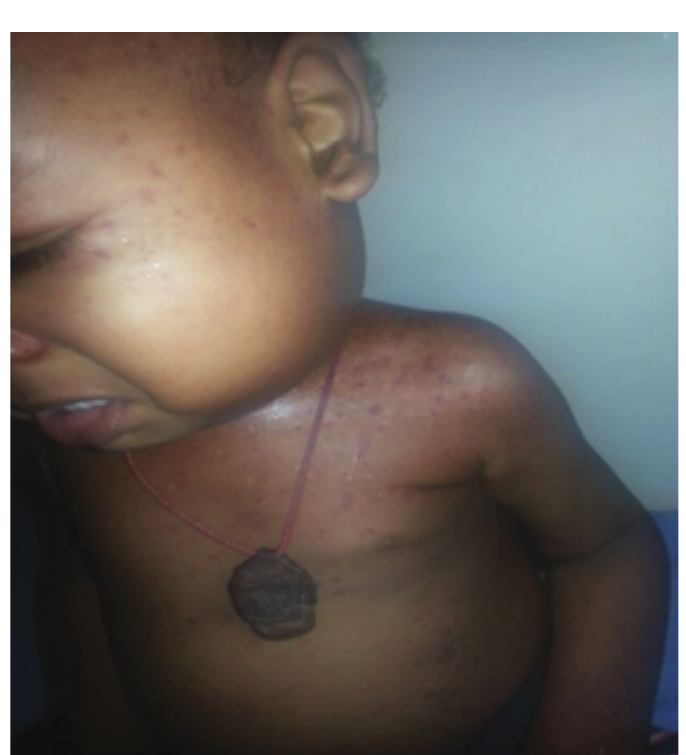
Figure 5: Facial edema and purpura of the face and